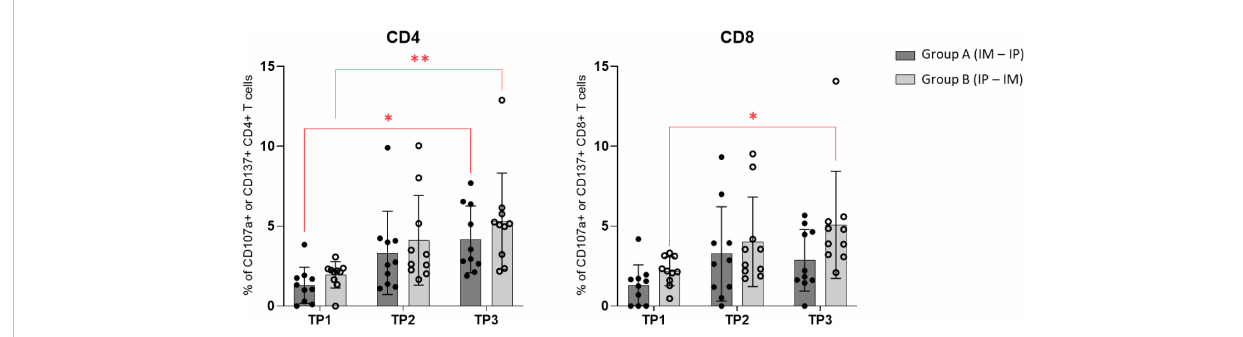
FIGURE 6 CD107a and CD137 activation markers staining: Comparison of CD4+ and CD8+ T cells expression of activation markers CD107a and CD137 in groups A and B at three timepoints by using Wilcoxon matched pairs signed rank t ‐ test.